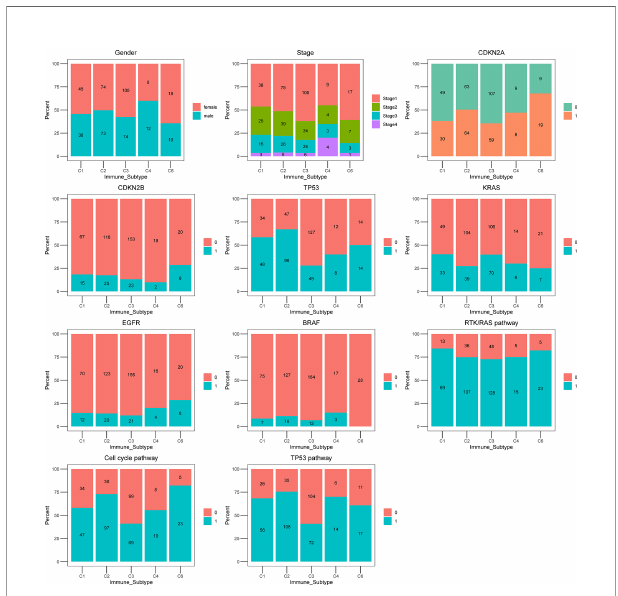
FIGURE 4 | The proportion of clinical and molecular features of TCGA LUAD cohort according to fi ve ISs. Bar plots showing the proportion of gender, stage, CDKN2A , CDKN2B, TP53 , KRAS , EGFR , BRAF , RTK/RAS pathway, Cell cycle pathway, and TP53 pathway in immune subtypes C1 (wound healing), C2 (IFN-g dominant), C3 (in fl ammatory), C4 (lymphocyte depleted) and C6 (TGF- b